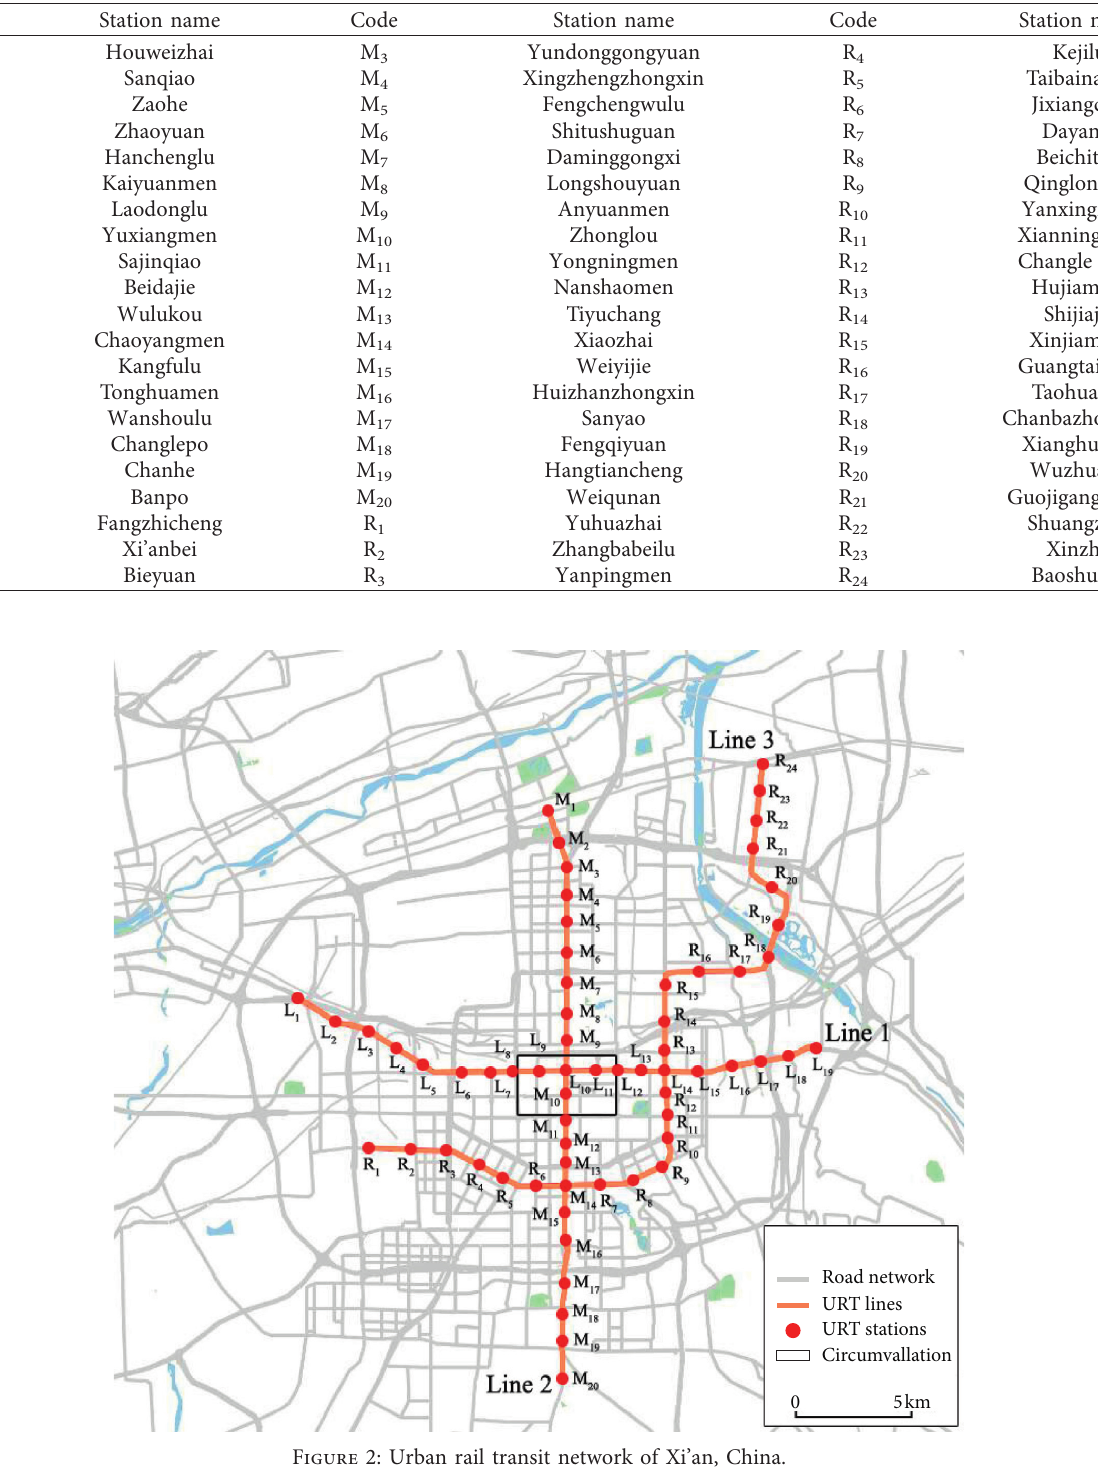
Table 1: Coding for urban rail transit stations in Xi’an, China.